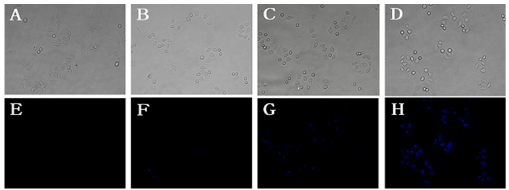
Figure 6. Images of living HeLa cells: HeLa cells incubated with probe 1 (10 µM) for 1 h and then with different concentration of CN − (( A , E ) 0 µ M; ( B , F ) 10 µ M; ( C , G ) 80 µ M; ( D , H ) 160 µ M) for 15 min.